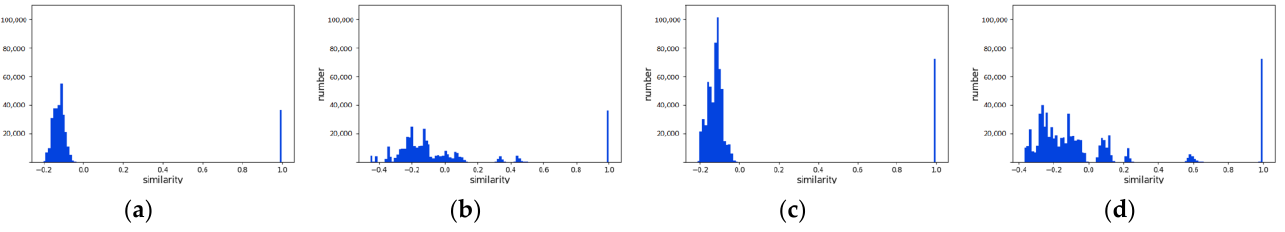
Figure 13. Distribution of similarity over the Pavia University dataset, when epoch = 300: ( a ) 𝑇 = 0.25, ℎ = 10; ( b ) 𝑇 = 1.0, ℎ = 10; ( c ) 𝑇 = 0.25, ℎ = 20; ( d ) 𝑇 = 1.0, ℎ = 20.